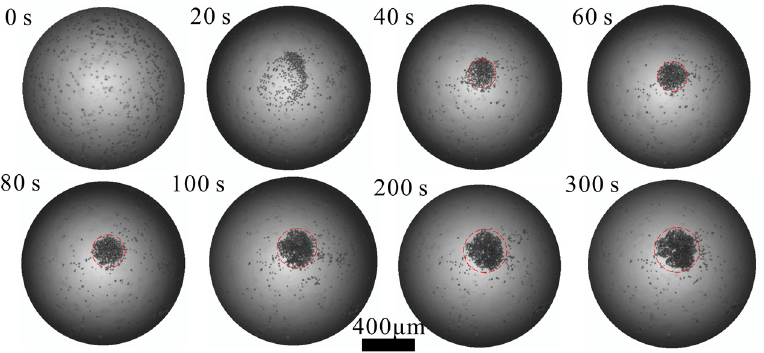
Figure 5. Time-series images of 10 µ m particle concentration process. (Supplemental Movie S4) The images were taken at the h = 0. The equivalent diameter of the concentrated region at 40, 60, 80, 100, 200, 300 s are 216, 228, 265, 306, 340, 356 μ m respectively.